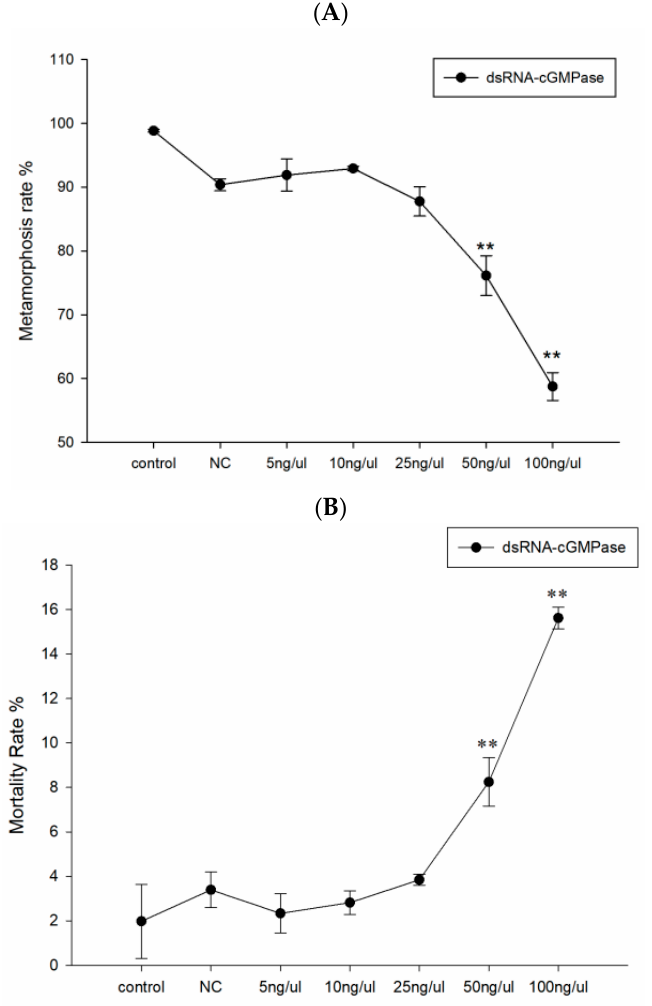
Figure 6. During the DVE-UMBO, different dsRNA concentrations interfered with metamorphosis ( A ) and mortality rates ( B ) of cGMPase in larvae. Double asterisks mean a highly significant difference (** p < 0.01).